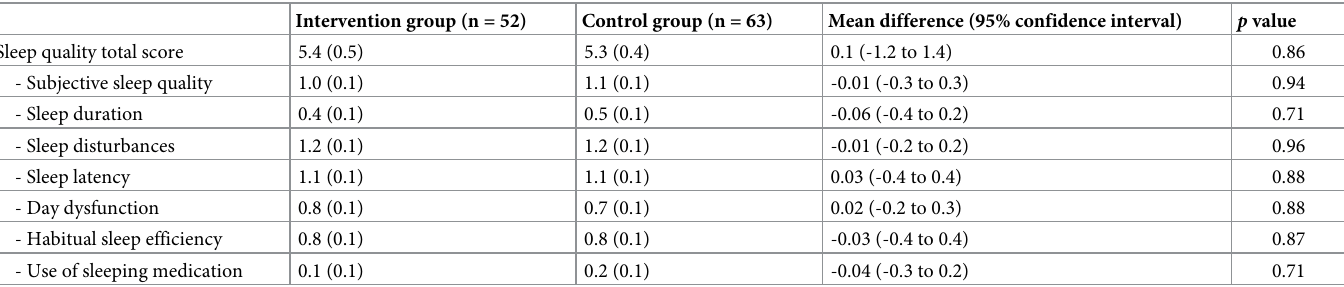
Table 4. Sleep quality measured by the PSQI, five years after lifestyle intervention according to allocation status.